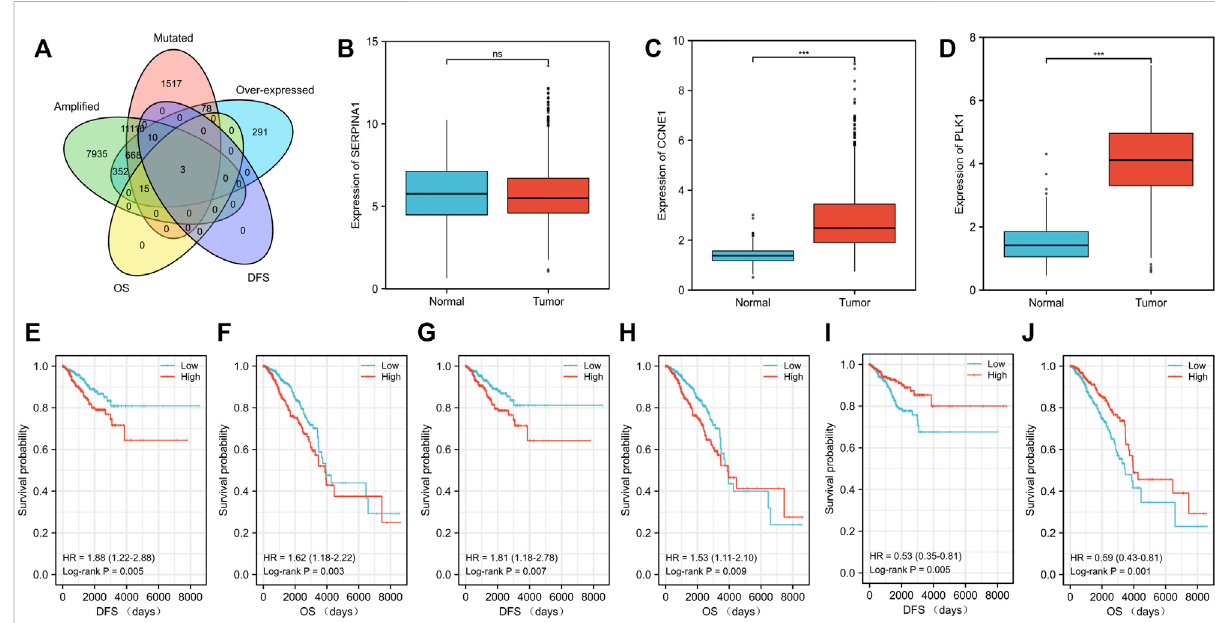
FIGURE 2 Identi fi cation of tumor antigens related to the prognosis of patients with breast cancer (BC). (A) Venn diagram showing the potential tumor antigens (total 701) with mutation, ampli fi cation and overexpression, and signi fi cant association with both disease-free survival (DFS) and overall survival (OS) ( p < 0.01) (total three hub genes). Differential expression levels of three hub genes including (B) SERPINA1 , (C) CCNE1 , and (D) PLK1 betweenbreastcancertissueandnormaltissue.Theprognosticvalueofthreepotentialantigens.TheKaplan – MeiercurvesshowingtheDFSof patients withbreastcancer strati fi edbasedon theexpressionlevel of (E) CCNE1 , (G) PLK1, and (I) SERPINA1 and theOS onthebasis of (F) CCNE1 , (H) PLK1 , and (J) SERPINA1 . The cohort was divided into low- and high-risk groups with median expression as the cutoff. P < 0.05 was considered statistically signi fi